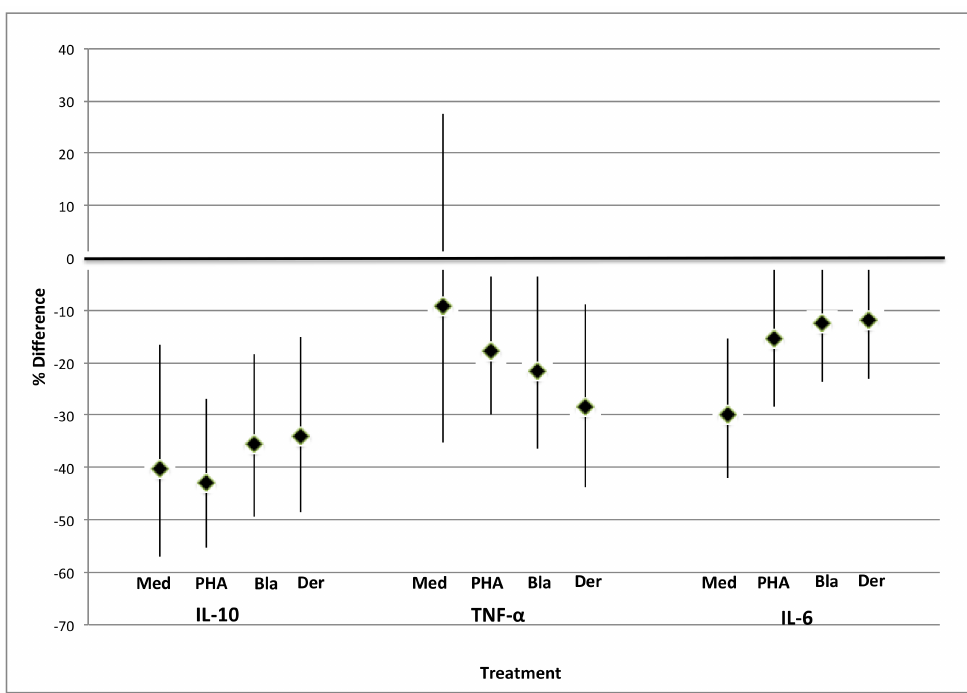
Figure 1. Percent difference in cord blood cytokine concentrations per µ g/m 3 increase in PM 2.5 exposure. Unstimulated (Med) IL-10 was analyzed using Tobit regression; others were analyzed using linear regression. Models were adjusted for maternal age, race/ethnicity, education, household income, child sex, the season of birth, pre-pregnancy BMI, and smoking. PM 2.5 exposure was averaged over